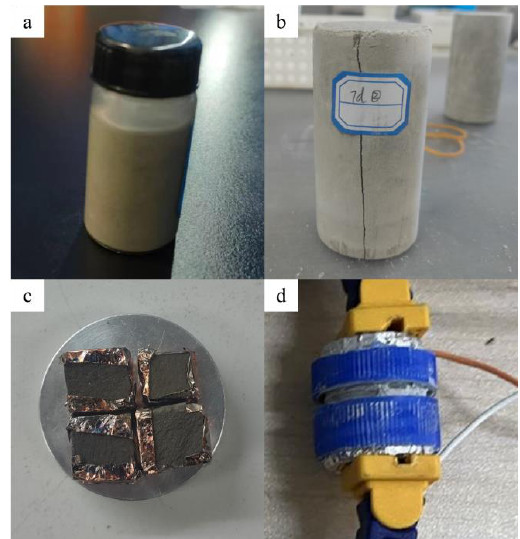
Figure 4. Schematic diagram of experimental materials: ( a ) CFTFS by NMR analysis; ( b ) CFTCB by UCS; ( c ) CFTCB by SEM; ( d ) CFTFS by volume resistivity experiment.